Question: What type of chart is this?
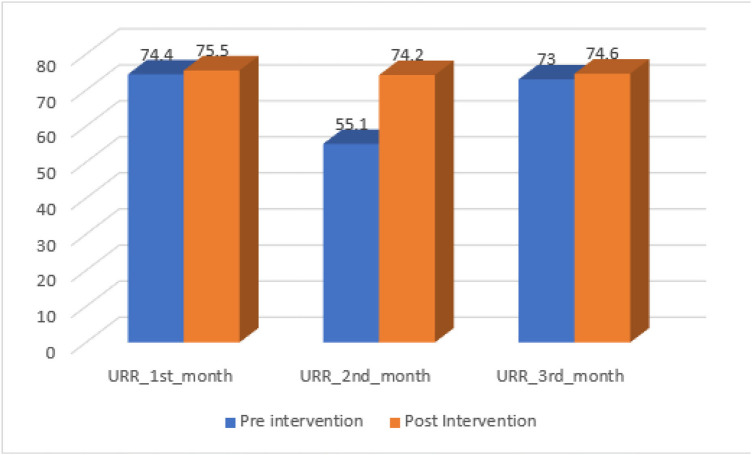
Answer: bar